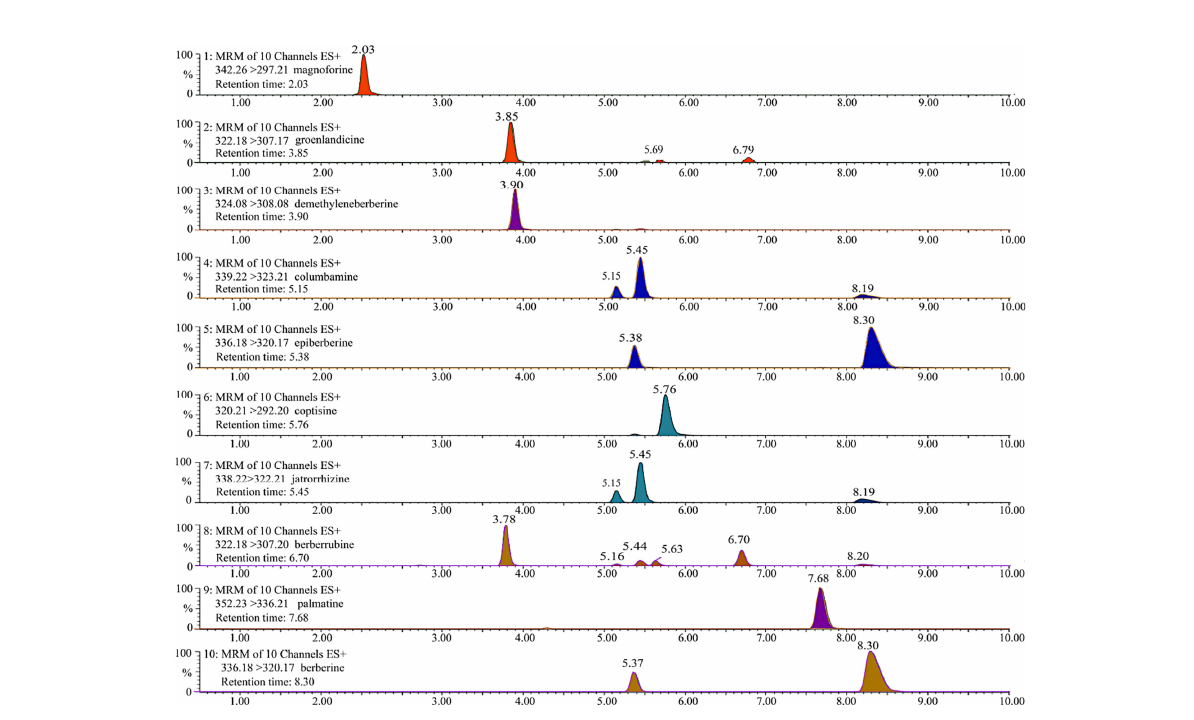
FIGURE 3 The representative MRM pro fi les of 10 alkaloids in RC drugs based on UPLC/QqQ-MS technique. These compounds were detected in positive ion mode, and all target alkaloids are excellently separated according to their retention time and ion fragment